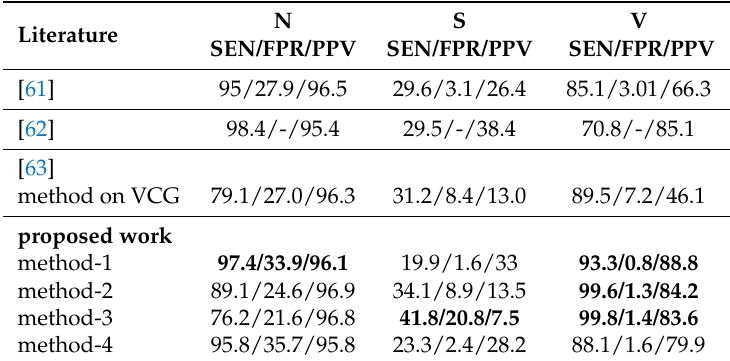
Table 29. Performance comparison with recent literature (N, S, and V